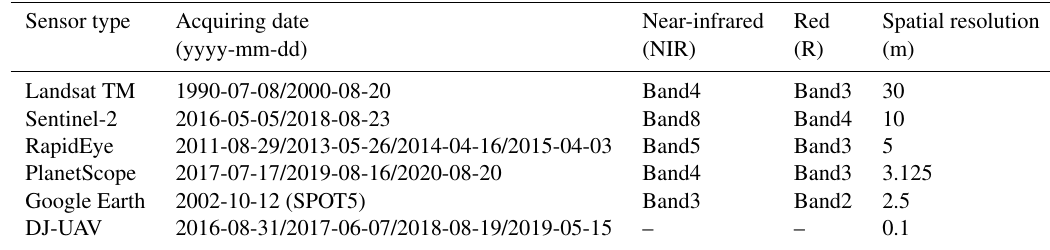
Table 1. Satellite/UAV data used to map the PSF extents.